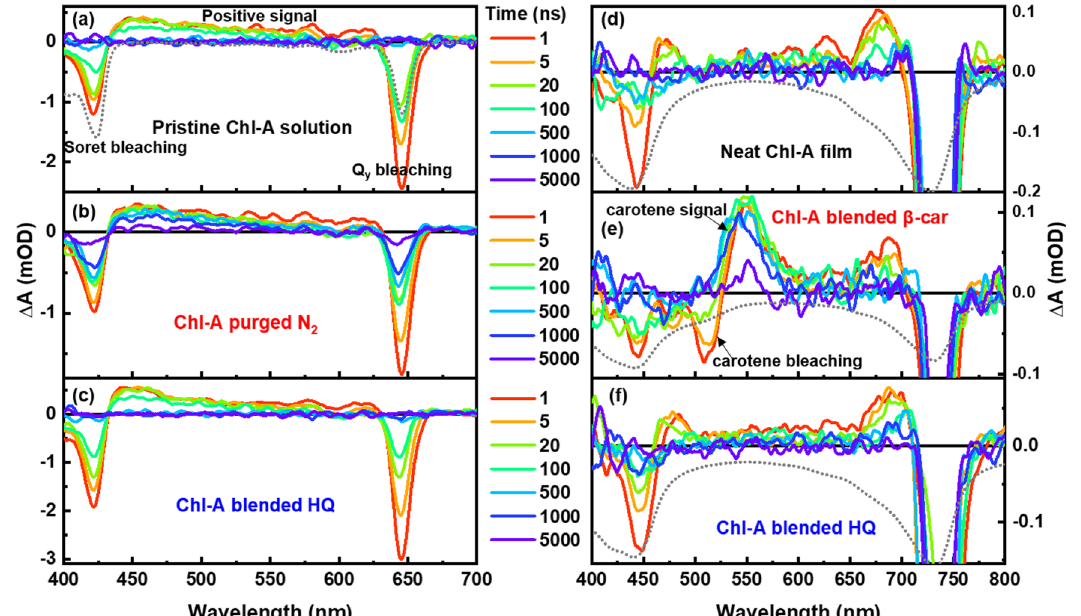
Fig. 2 Photo-induced TA spectra of Chl-A solution and fi lm. a The pristine Chl-A solution and the ones ( b ) purged with N 2 gas or ( c ) blended with HQ excited at 650 nm ( Q y band of Chl-A solution), and ( d ) a neat Chl-A fi lm and the ones blended with ( e ) all- trans - β -carotene or ( f ) HQ excited at 737 nm ( Q y band of Chl-A fi lm). The gray broken-dotted line represents the inverted steady-state absorption spectrum of each sample for